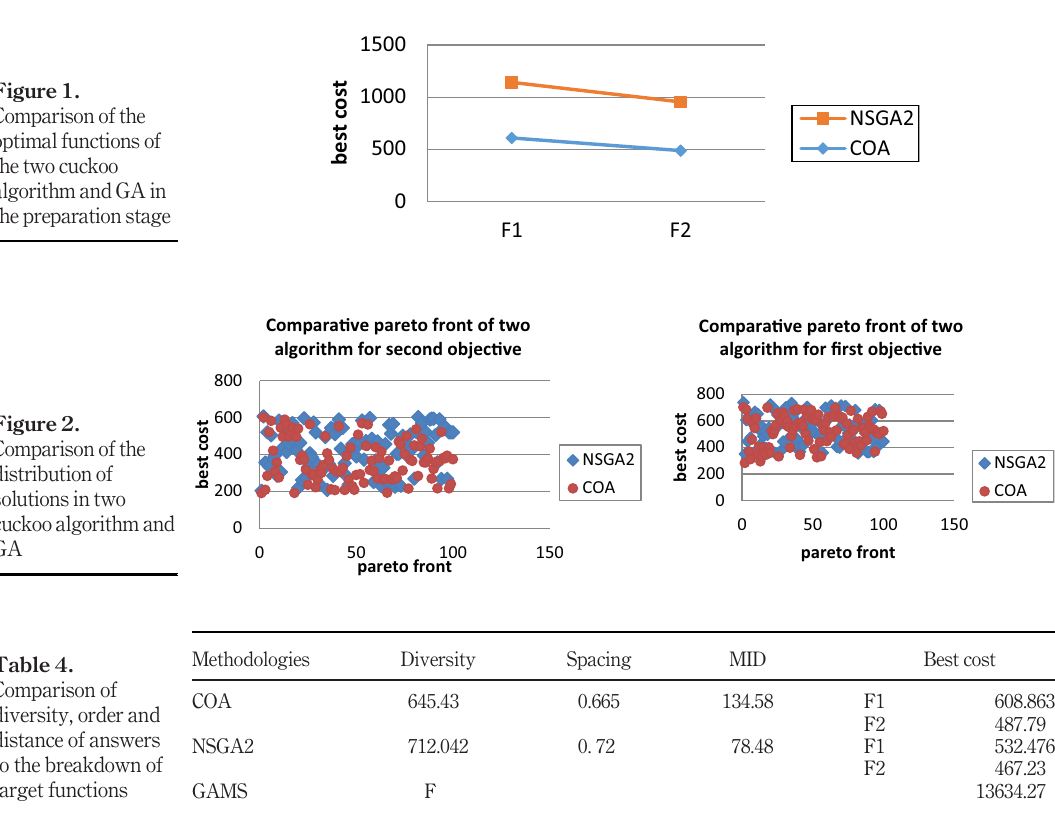
Figure 2. Comparison of the distribution of solutions in two cuckoo algorithm and GA